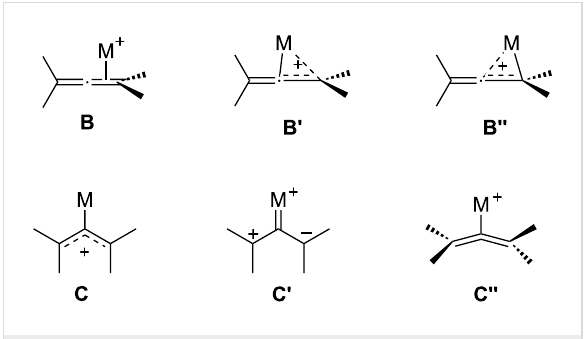
Figure 2: Proposed structures for gold-activated allene